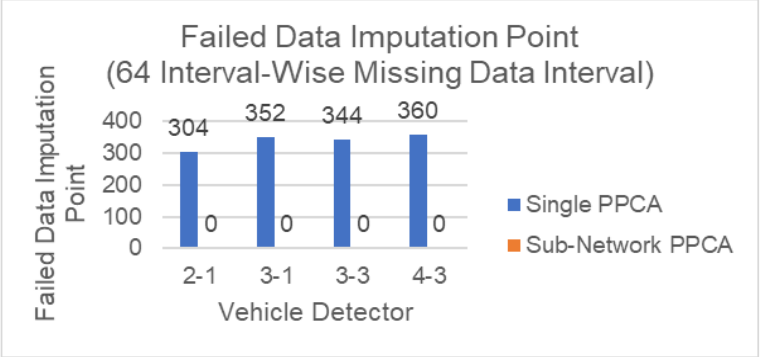
Figure 12. Failed data imputation points for in Scenario B for 64 interval-wise missing data inter- vals.